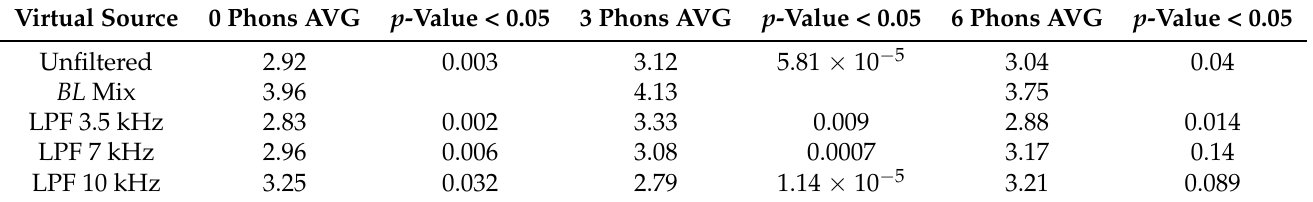
Table 7. T -test Results—mix